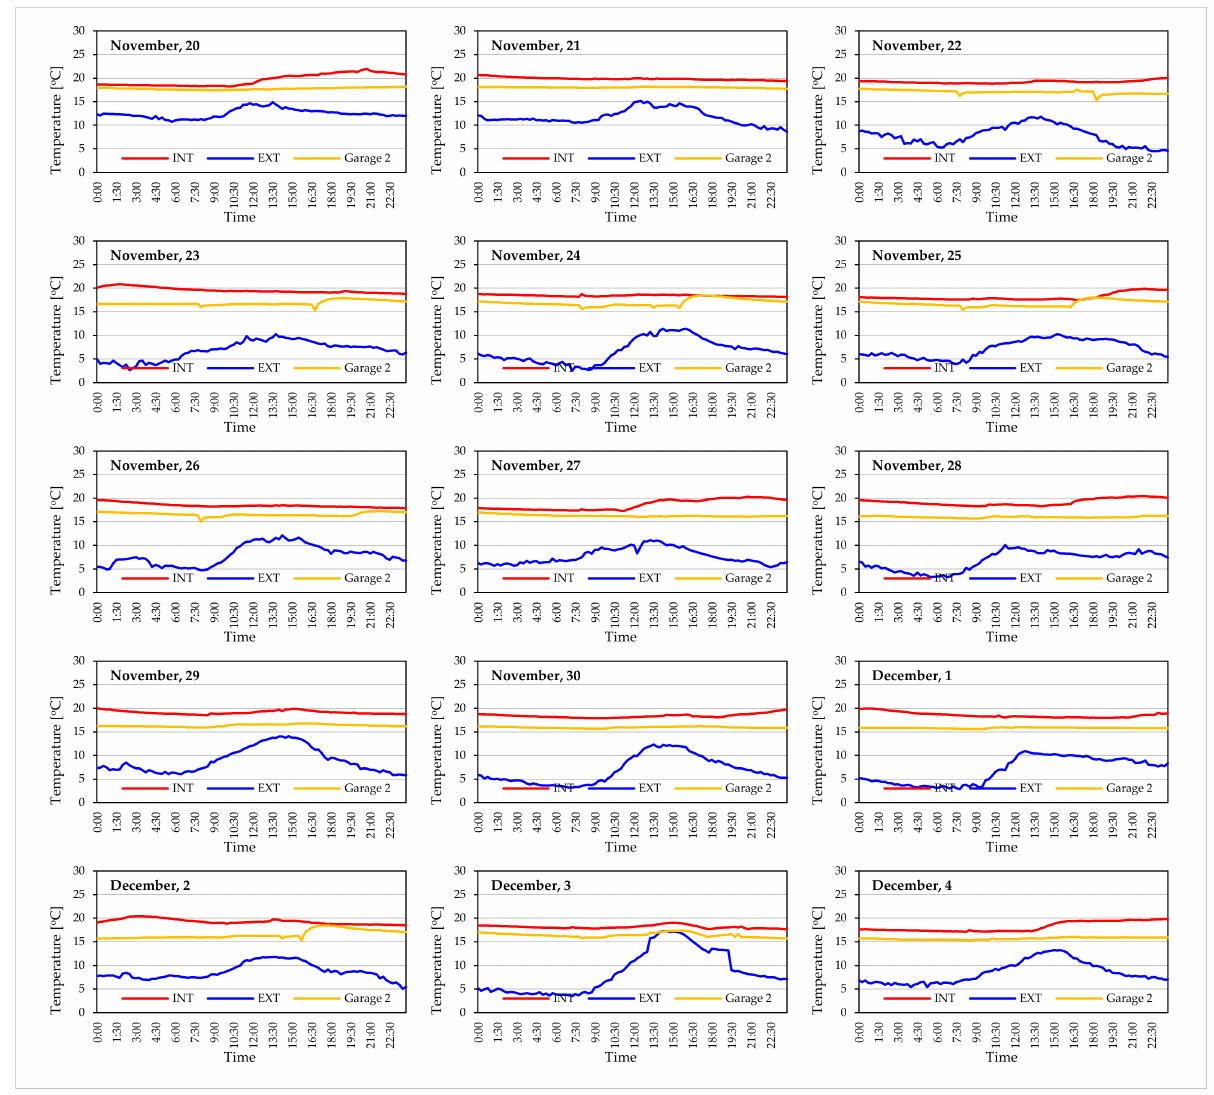
Figure 15. Daily temperature profile in the Garage 2.